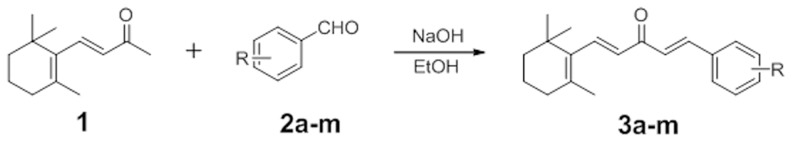
General route for the synthesis of 13 β-ionone and benzaldehyde analogues (3a−m).1 =  β-ionone, 2a−m = 13 forms of benzaldehyde, 3a−m = 13 analogues of β-ionone and benzaldehyde. R is listed in Table 1.